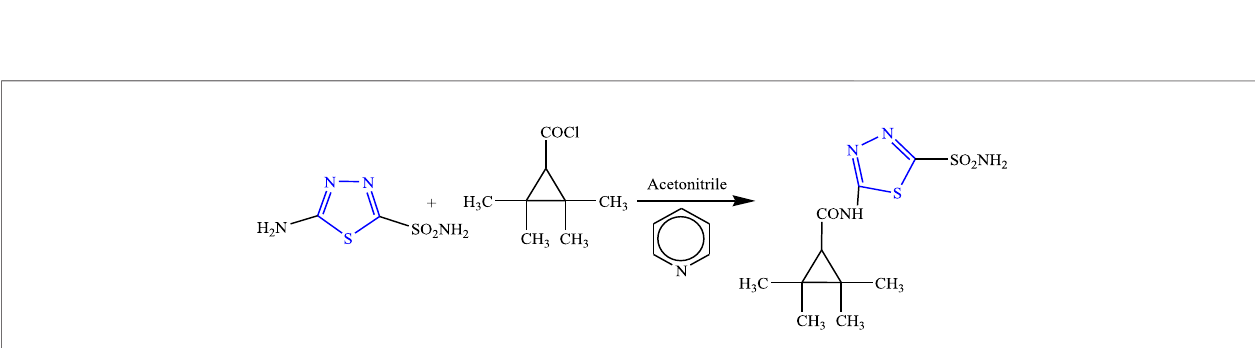
FIGURE 29 | Systematic scheme for synthesizing targeted aryl-substituted 1,3,4-thiadiazole derivatives.